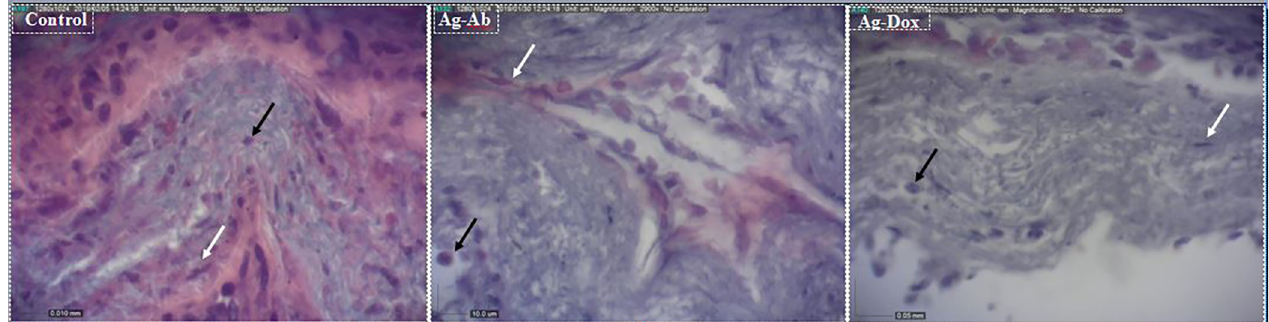
Fig 11. Histological changes to the grafted MCF7 scaffolds; recruitment of the inflammatory (black arrows) and fibroblast cells (white arrows) occurred at different proportions.